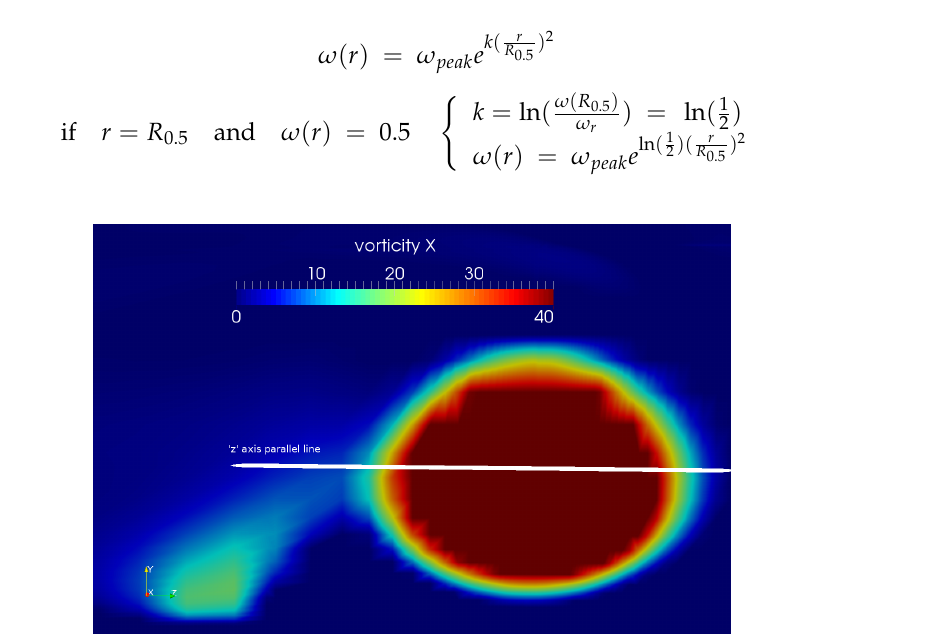
Figure 6. Vorticity distribution in a spanwise plane normal to the free stream velocity at x distance from the VG trailing edge. Primary and secondary vortexes with a vorticity field are shown in a normal plane to the free stream velocity. The white horizontal is parallel to the z-axis and passes through the vortex